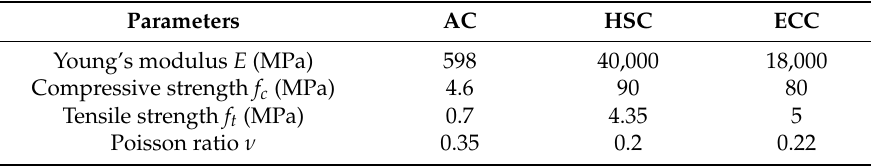
Basic properties of the materials in the multi-layer pavement in the drop weight test. Table 9.